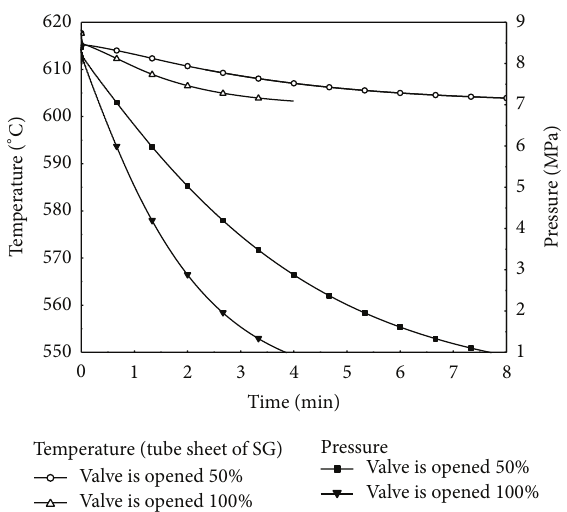
Figure 9: Temperature and pressure transient during depressuriza- tion.